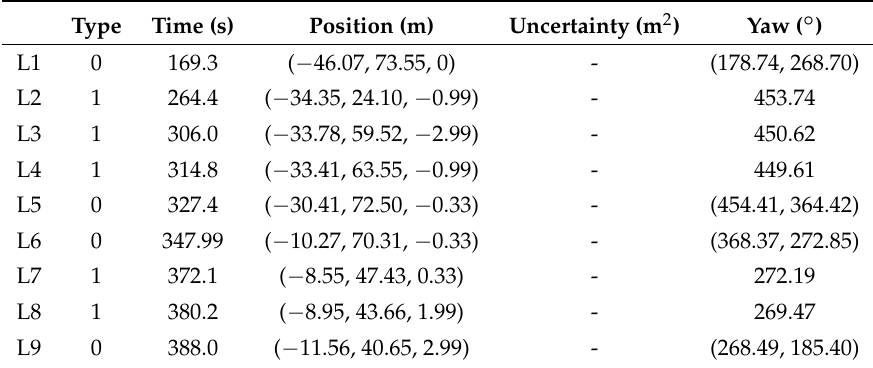
Table 4. Part of the Data Base Generated for the Trajectory Depicted in Figure